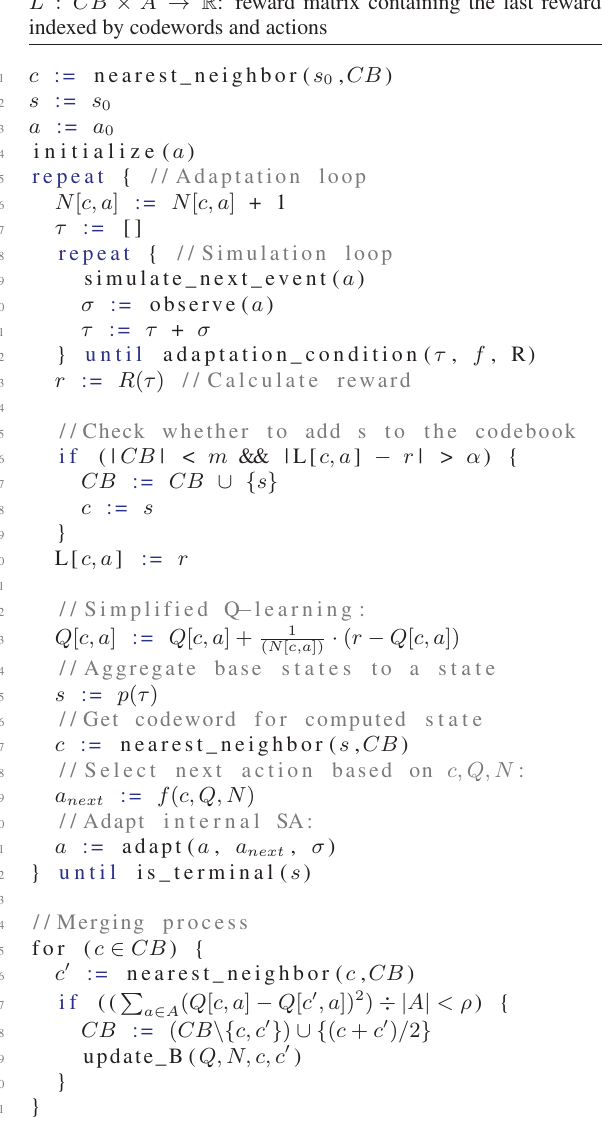
Figure 2: State space partitionings built by using the changed AVQ with m = 10 (left) and m = 100 (right).